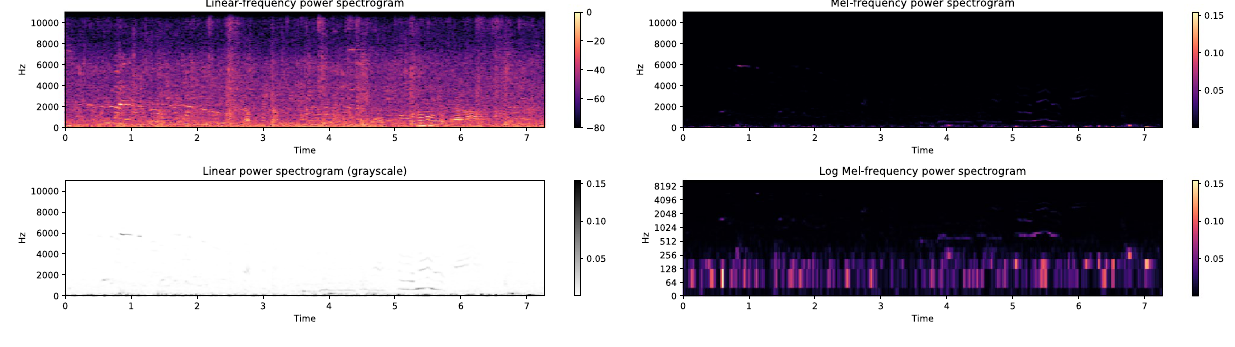
Figure 3. STFT spectrogram and Mel spectrogram.